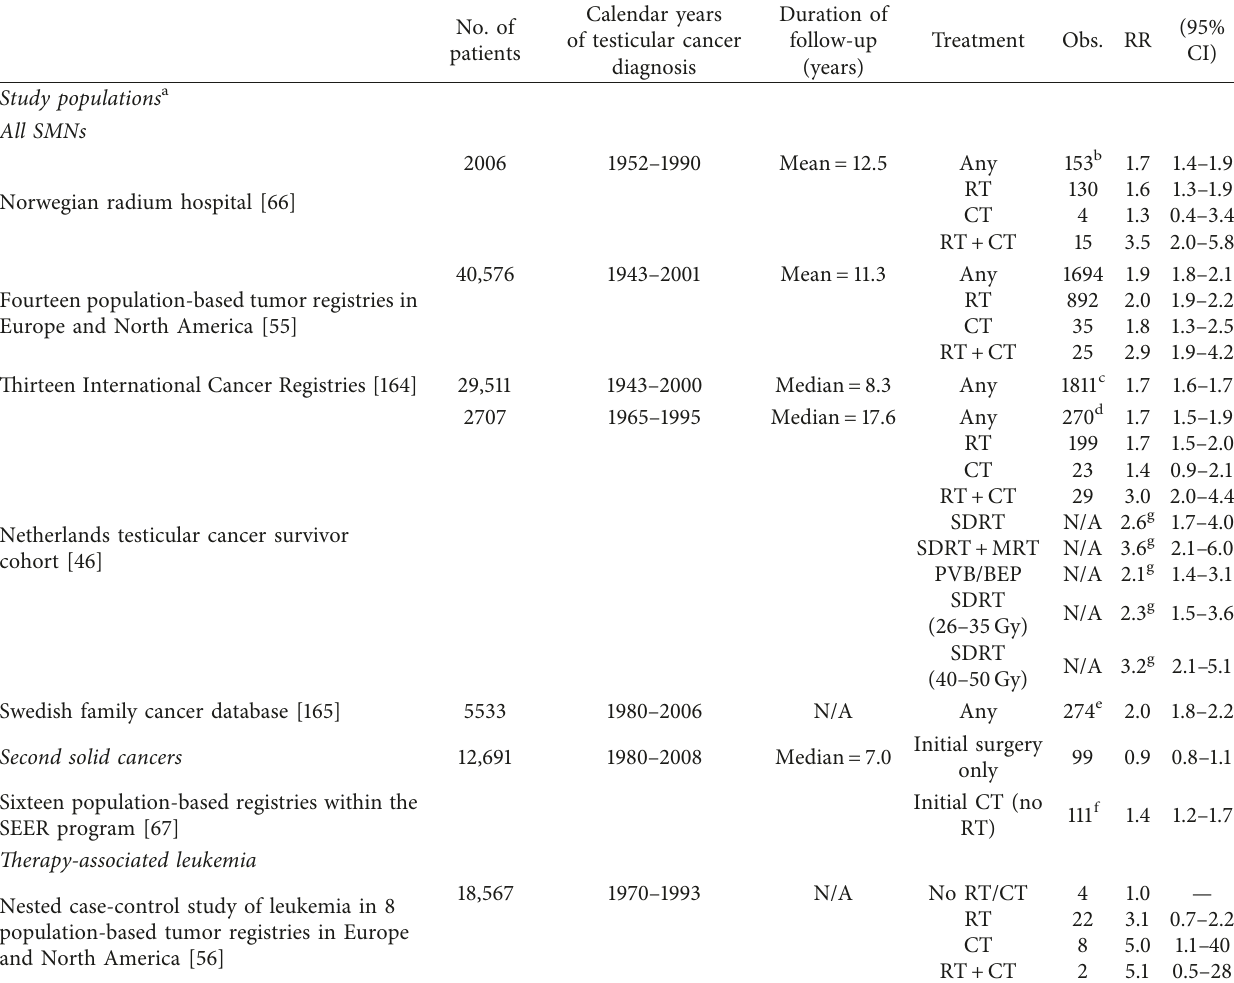
Table 2: Relative risks of second malignant neoplasms (SMN) in testicular cancer